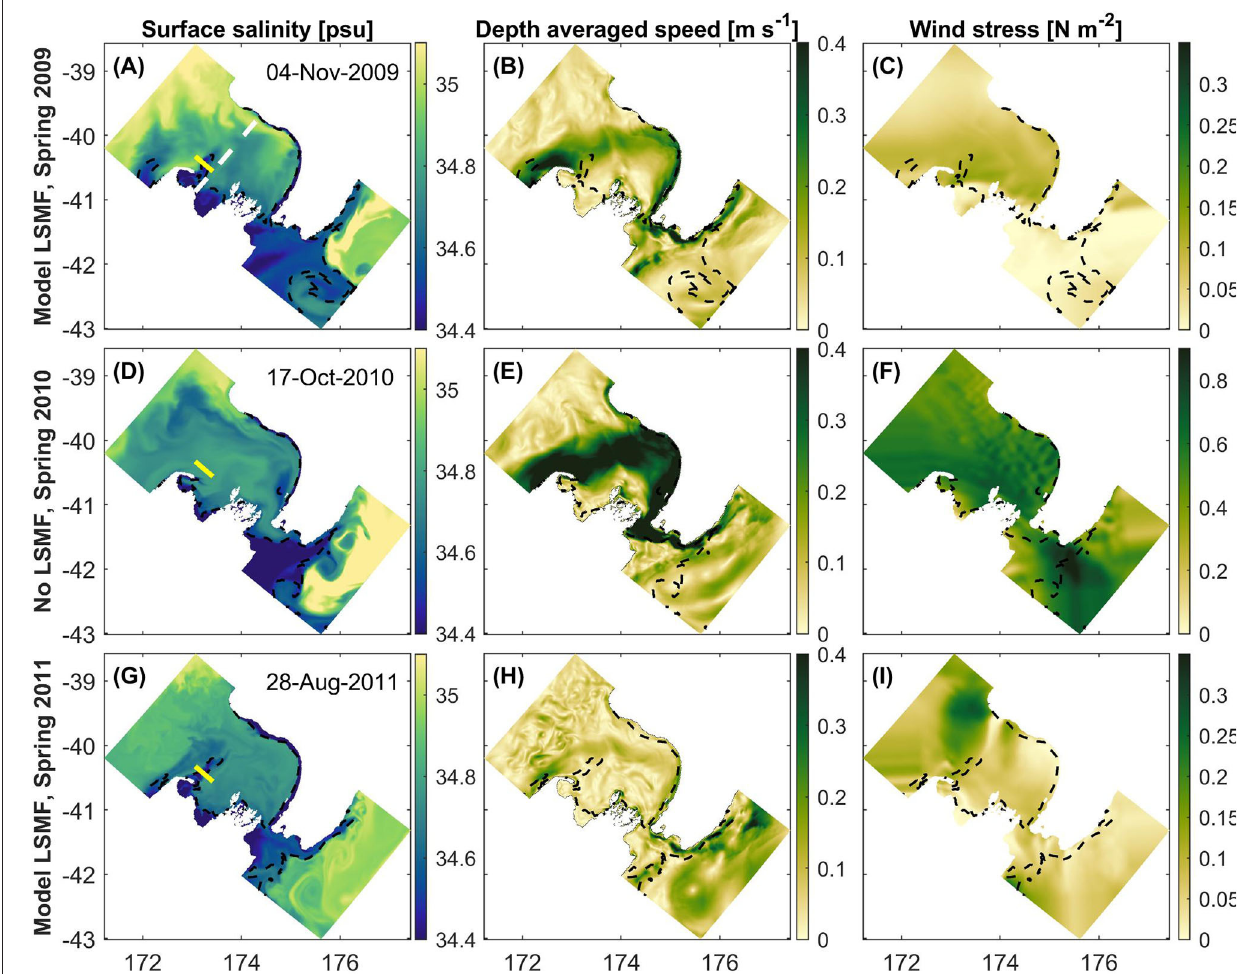
FIGURE 8 | Map of modeled domain and modeled results of (A,D,G) surface salinity, (B,E,H) depth averaged speed, and (C,F,I) magnitude of wind stress on November 4, 2009 (top panel), October 17, 2010 (middle panel), and August 28, 2011 (bottom panel) at 18:00. White dashed line (A) is the transect defined for the calculation of d’Urville Current transport in Greater Cook Strait. 34.6 psu contour was overlayed in black dashed line in each subplot. Yellow lines in (A,G) are transects chosen to analyse the vertical structure during each the two modeled LSMFs and in (D) during the absence of a modeled LSMF. Note different colorscales used for wind